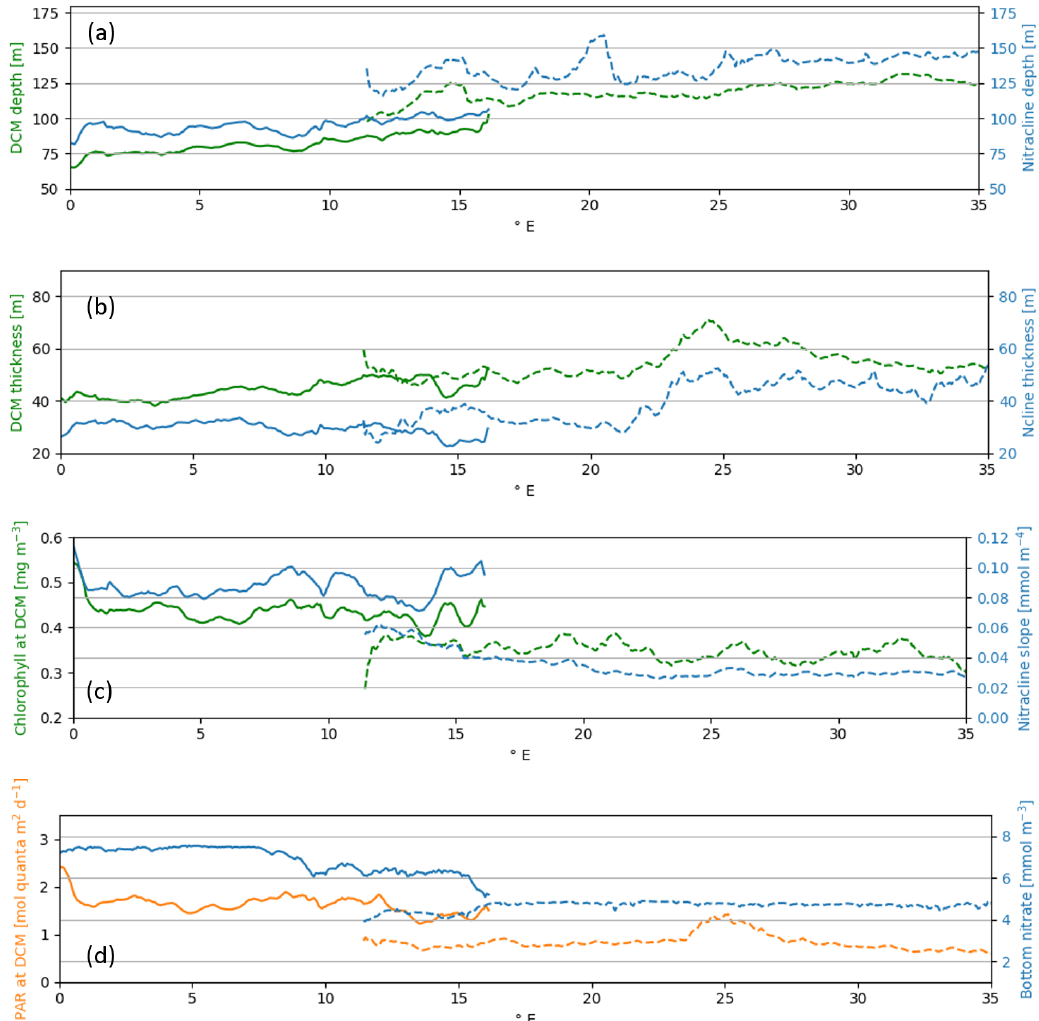
Figure 9. Meridional averages of summer water column indexes (Table 5) along red lines in Fig. 8 for western (continuous line) and eastern (dashed line) sub-basins: DCM (green) and nitracline (blue) depth [m] (a) ; DCM (green) and nitracline (blue) thickness [m] (b) ; DCM intensity (green) as chlorophyll concentration [mgm − 3 ] and nitracline slope (blue) [mmolm − 4 ] (c) ; PAR-at-DCM depth (orange) [molquantam − 2 d − 1 ] and bottom nitrate concentration (blue) [mmolm − 3 ] (d)